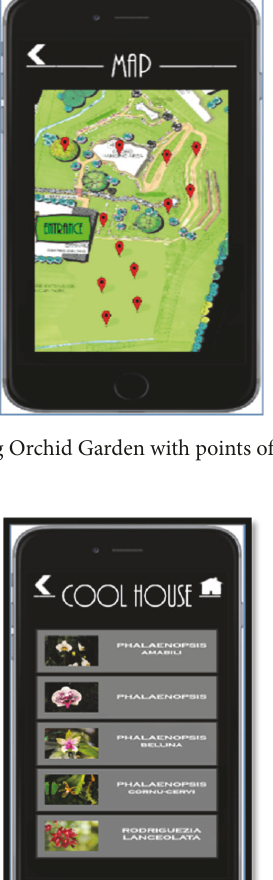
Figure 6: Information about orchid (front page).